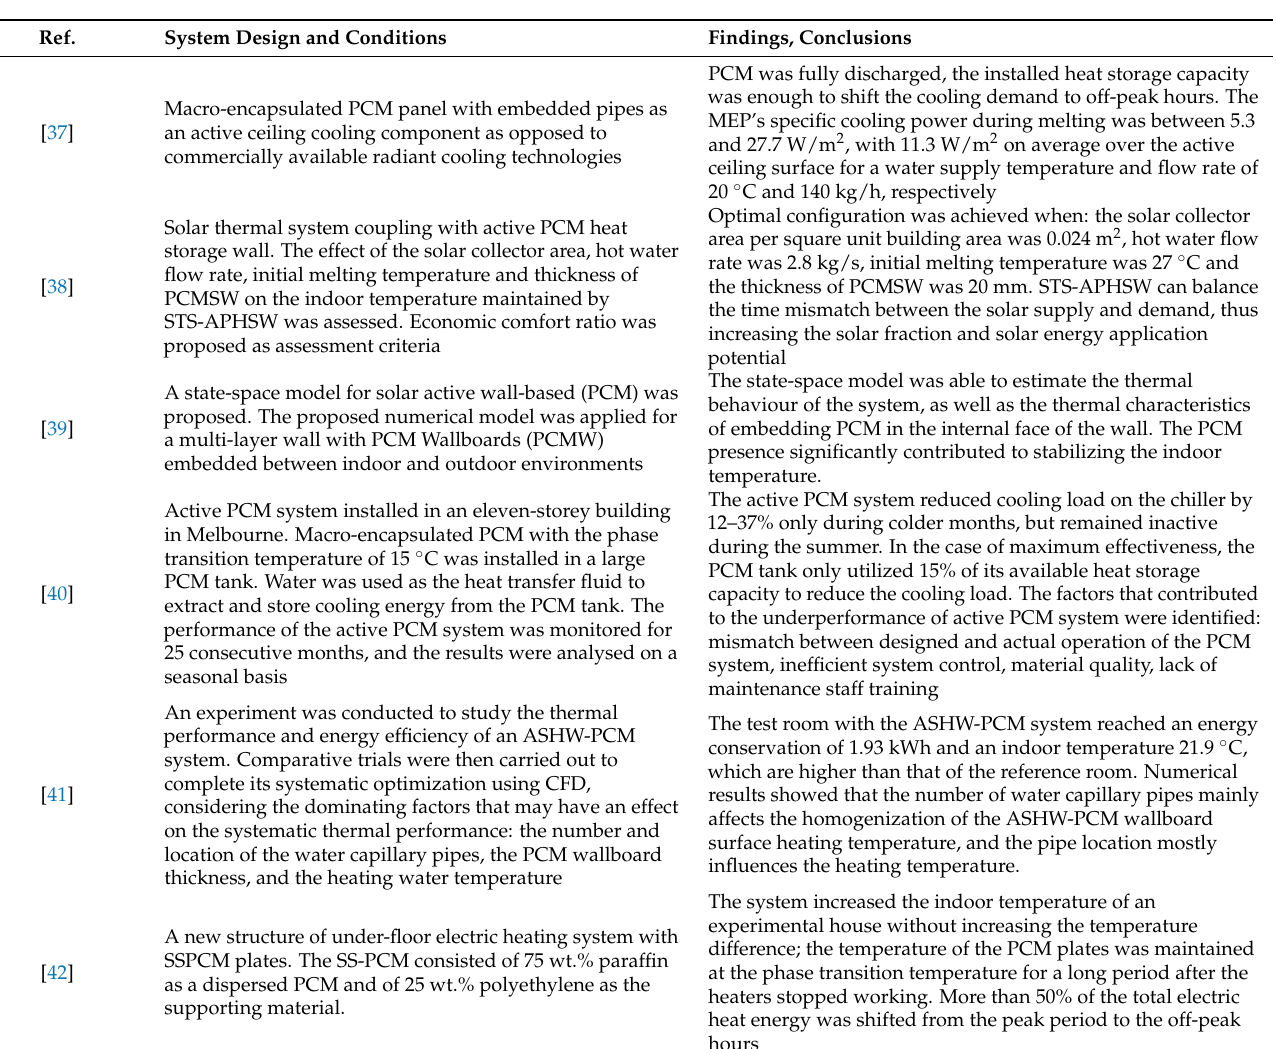
Table 2. Active PCM storage systems for the built